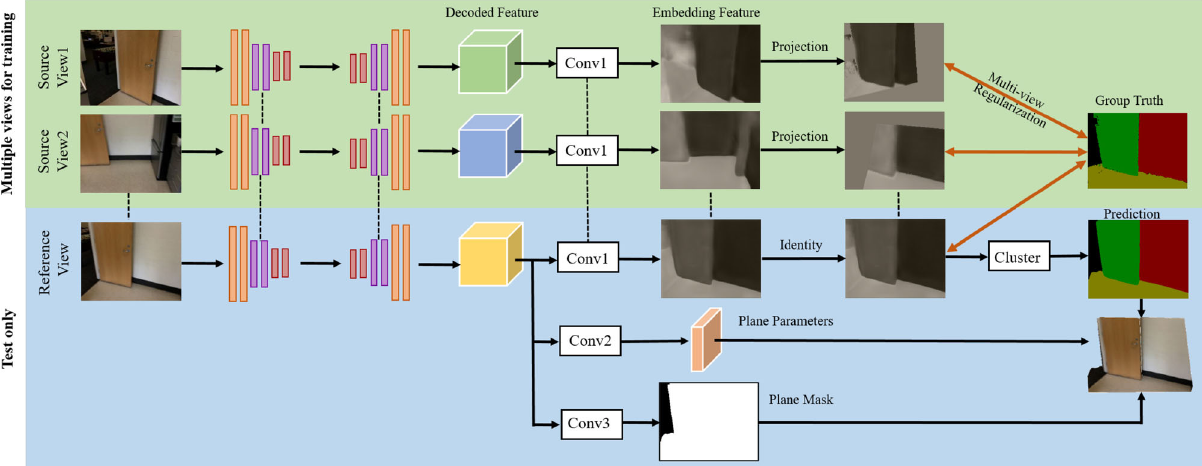
Fig. 2 The architecture of the proposed multiview regularization. At the training phase, the input of the network contains a reference image with annotation and K images under different views. The embedding features of the K source images are projected from their original views onto the reference view. At the test phase, only each color image is fed to the reconstruction network for 3D modeling separately and then composed in